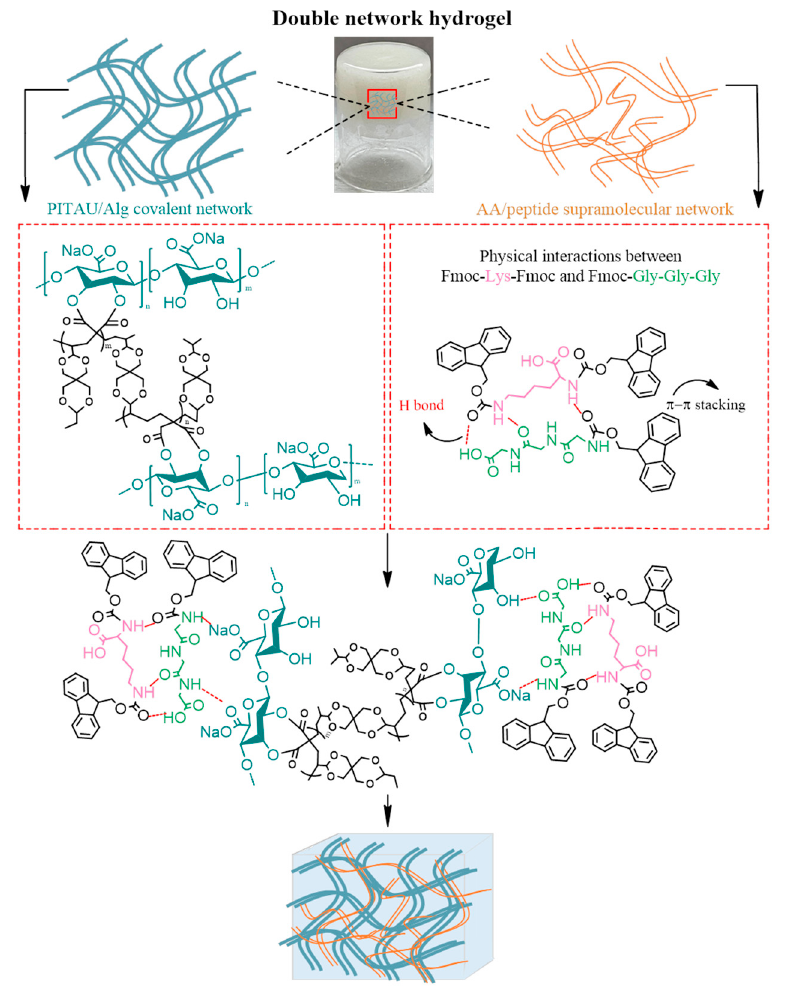
Figure 1. Illustrative scheme of the DN hydrogel formation with PITAU/Alg covalent gel as the first network and self-assembled peptides as the second